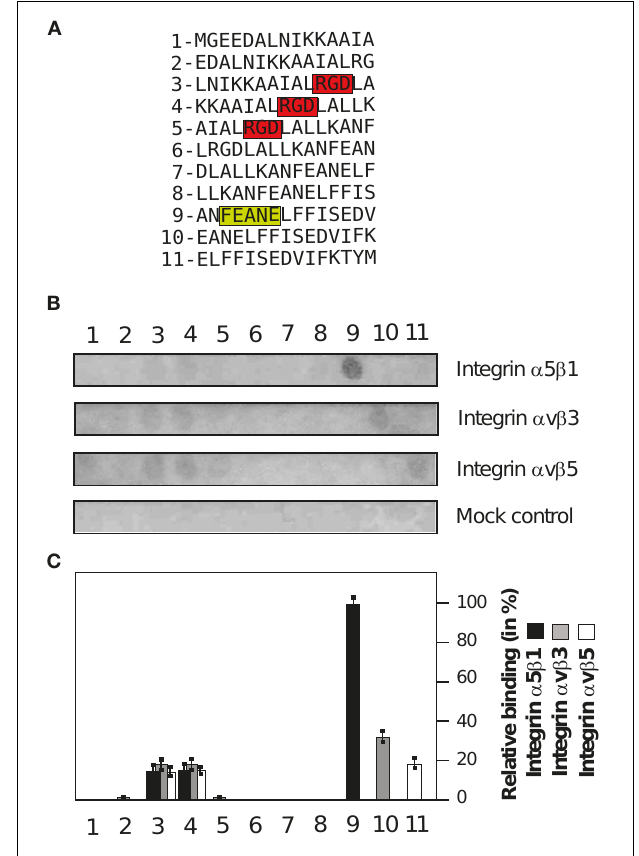
FIGURE 5 | Mapping of the RHS motif and flanking CagL sequences in binding to integrins using a peptide array. (A) The design of the array of 15-mer peptides and corresponding CagL amino acid sequences from position 60–104 is shown.The RGD and RHS motifs are highlighted with color. (B) Purified integrins α 5 β 1 , α V β 3 , and α V β 5 were incubated with these membranes and bound proteins were identified using antibodies as described in Materials and Methods. As a mock control, buffer-treated membranes followed by incubation with an integrin- β 1 antibody revealed no signals, as expected. (C) Densitometric measurement of individual spot intensities using the Lumi-Imager F1 (Roche) revealed the relative amount of bound binding partner per given peptide in%.The strongest spot intensity seen was set as